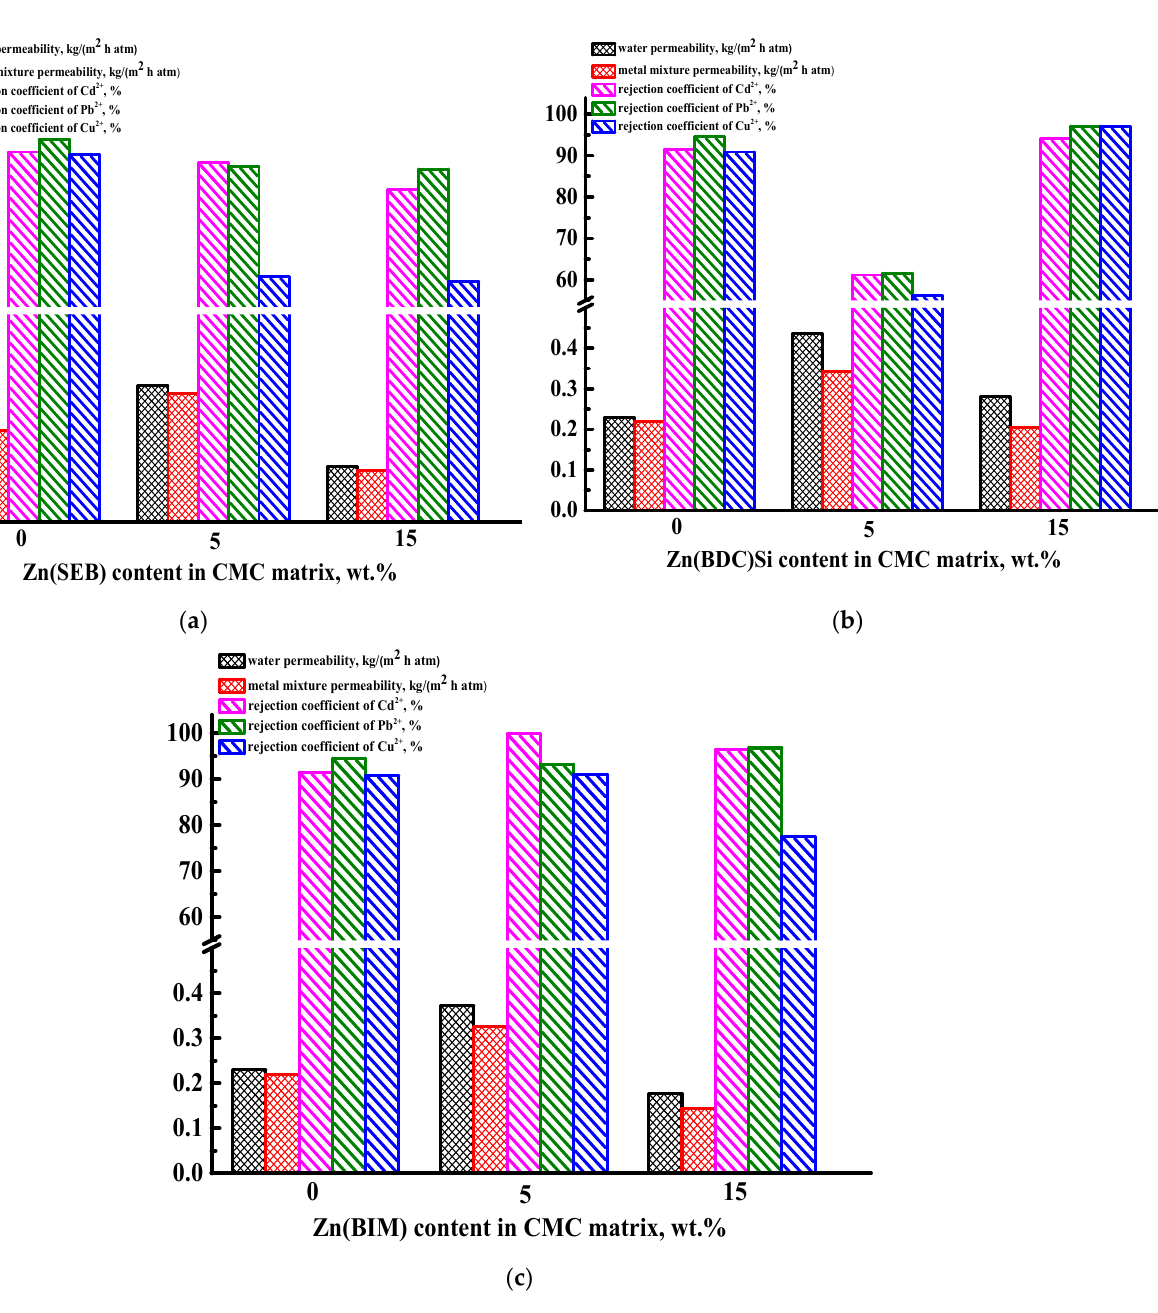
Figure 9. Transport properties in nanofiltration of water and a model solution of heavy metal ions (Cd 2+ , Pb 2+ , Cu 2+ ) of the supported ( a ) CMC/CA-15 and CMC + Zn(SEB)/CA-15 membranes, ( b ) CMC/CA-15 and CMC + Zn(BDC)Si/CA-15 membranes, and ( c ) CMC/CA-15 and CMC + Zn(BIM)/CA-15 membranes.